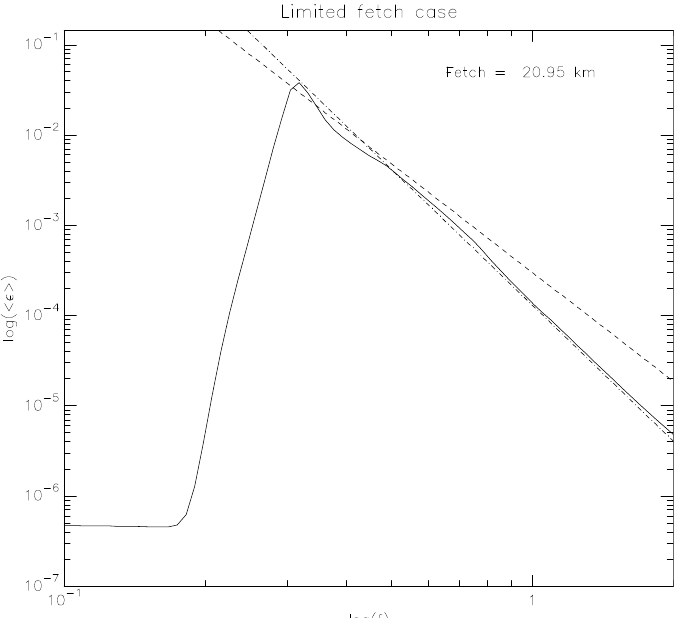
(cid:82) 2 π ε ( ω , θ ) d θ as 2 π 0